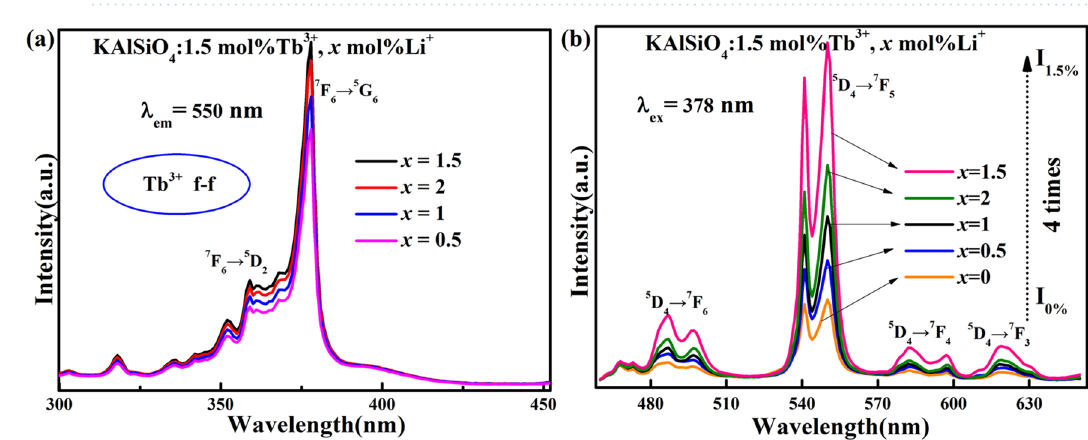
Figure 6. ( a ) Excitation spectrum and ( b ) emission spectrum of KAlSiO 4 : 1.5 mol% Tb 3+ , x mol% Li + series